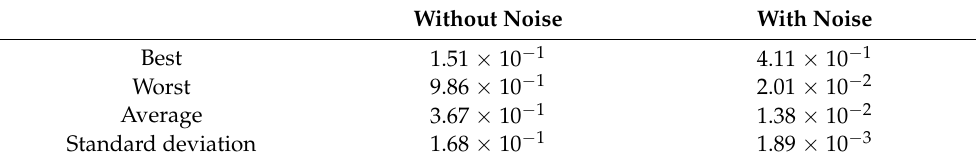
Table 6. Results for the experiments without considering noise and with the use of noise. Without Noise With Noise